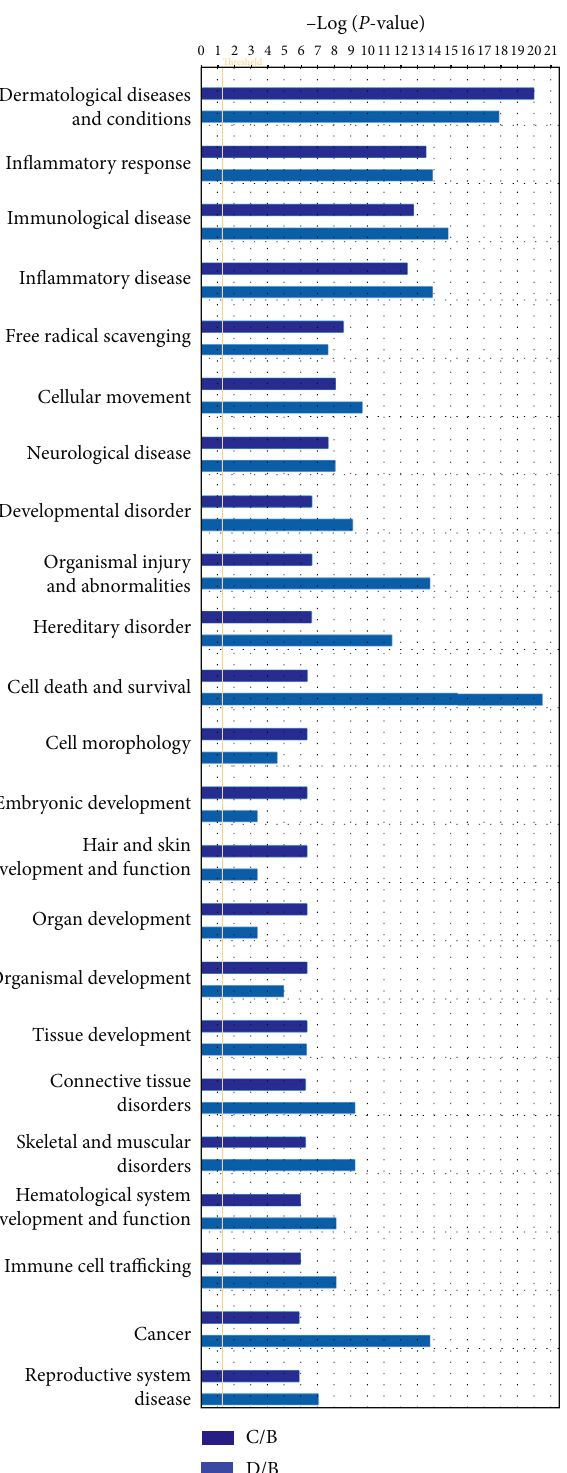
Figure 4: Classi fi cation statistics of di ff erential proteins about exudates in di ff erent periods. The dark blue column gram showed the classi fi cation of di ff erential proteins in C group (medium exudate) compared with B group (early exudate). The light blue column gram showed the classi fi cation of di ff erential proteins in D group (late e ff usion) than that of the B group (early e ff